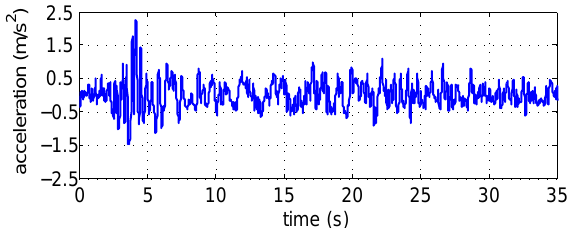
Figure 9: Full-scale North–South 1968 Hachinohe seis-